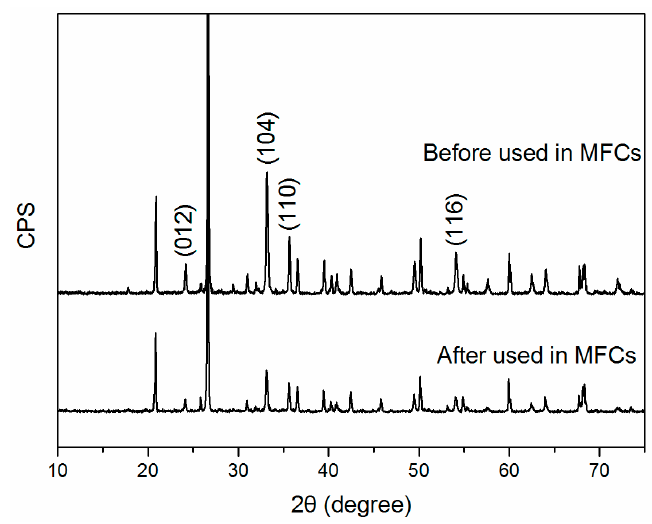
Figure 1. Powder XRD patterns of nature hematite before and after used in microbial fuel cells (MFCs).